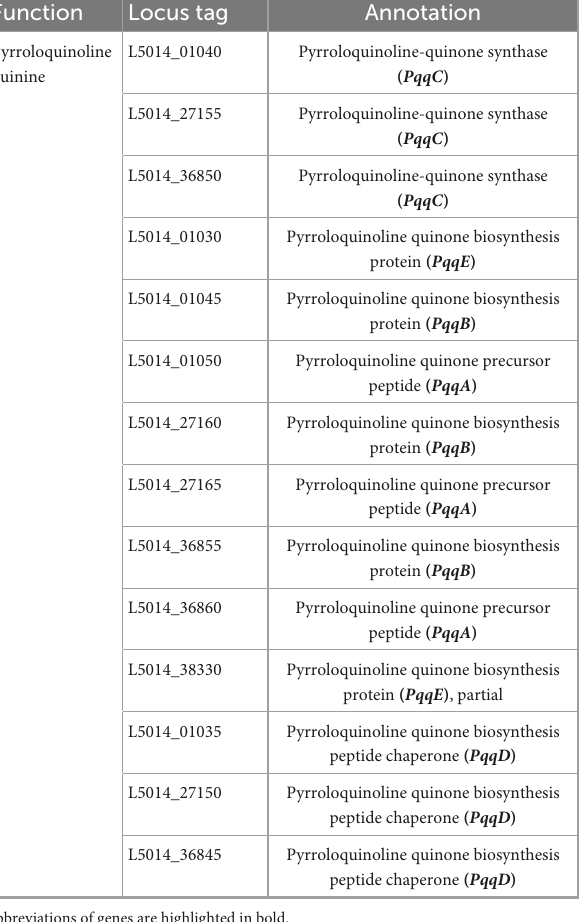
TABLE 4 Putative genes involved in the PGP in the genome of strain RG36 T .